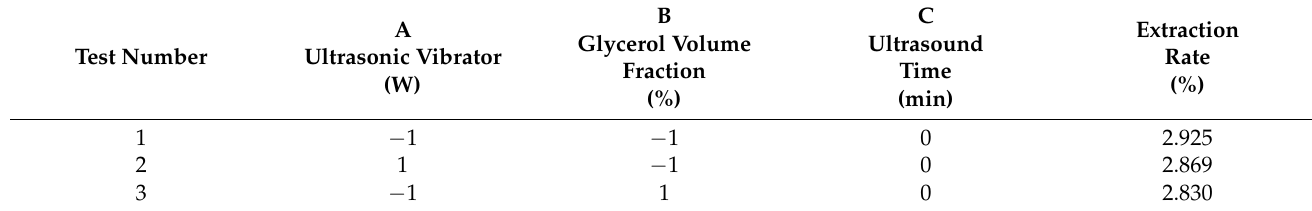
Table 4. Scheme and experimental results of response surface